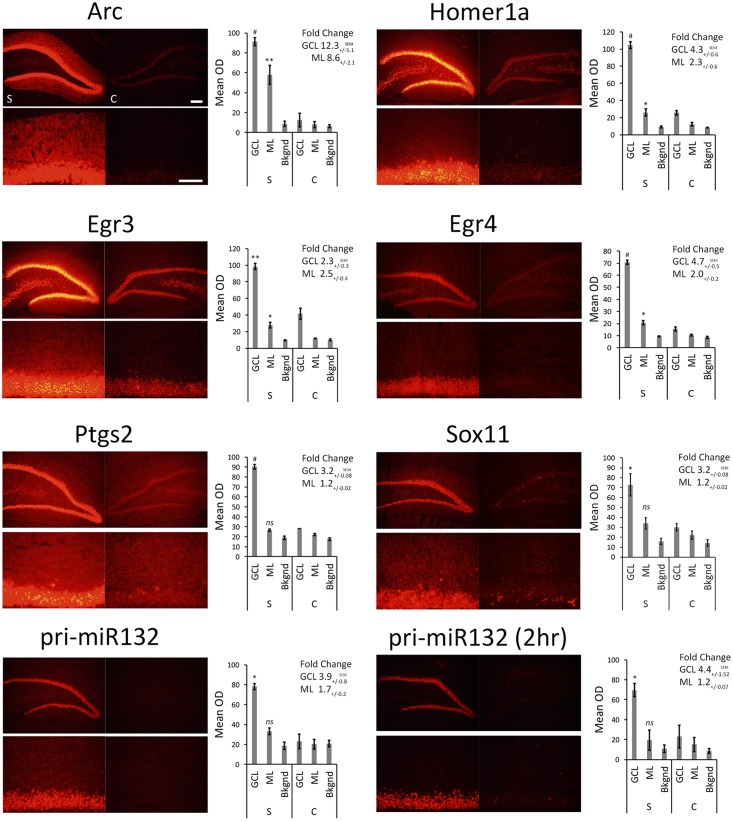
FISH for Arc, Egr3, Egr4, H1a, pri-miR132, Sox11, and Ptgs2. Rats were stimulated with pp-HFS and tissue was taken at the 4 h time point followed by FISH with transcript specific riboprobes. A 2 h time point is included for pri-miR132. Each slice was imaged at two different magnifications; zoom-out (top) and zoom-in (bottom). Control DG (right; c = control) and the stimulated DG (left; s = stimulated). The mean optical density of the in situ signal from the ML, GCL and background was quantified. (∗p < 0.05, ∗∗p < 0.005, #p < 0.001) ns, not significant. Error bars represent SEM. n = 3 per group. Zoom-out Scale Bar: 200 um. Zoom-in Scale Bar: 100 um.